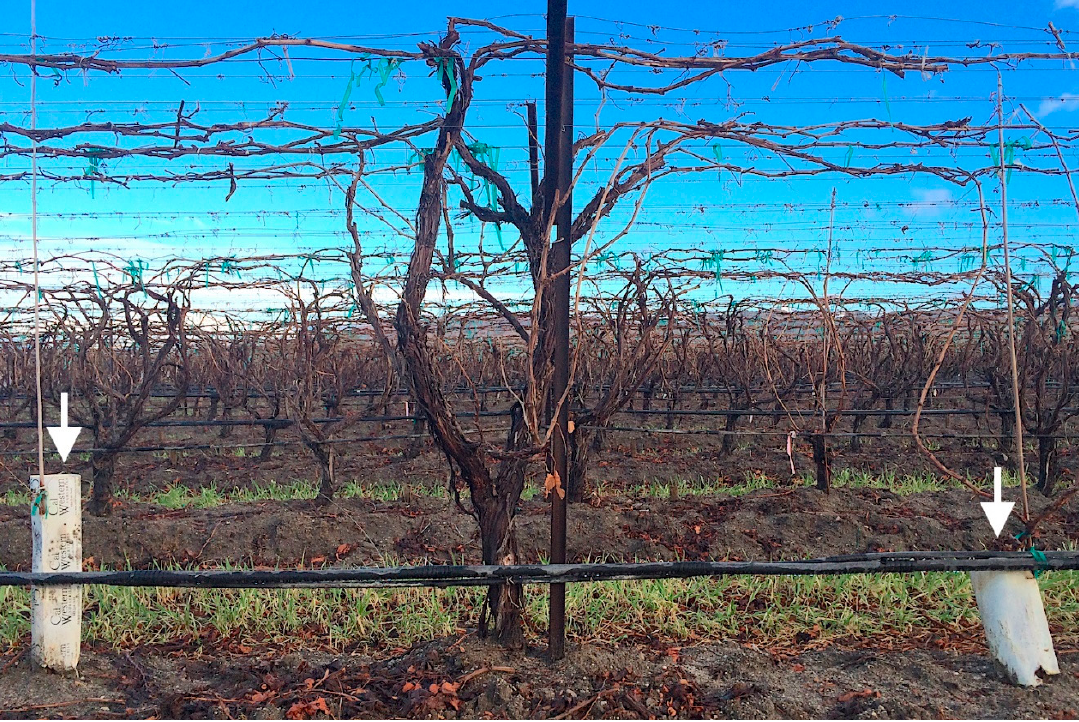
Figure 2. Vines replaced in recently planted vineyard (white arrows).